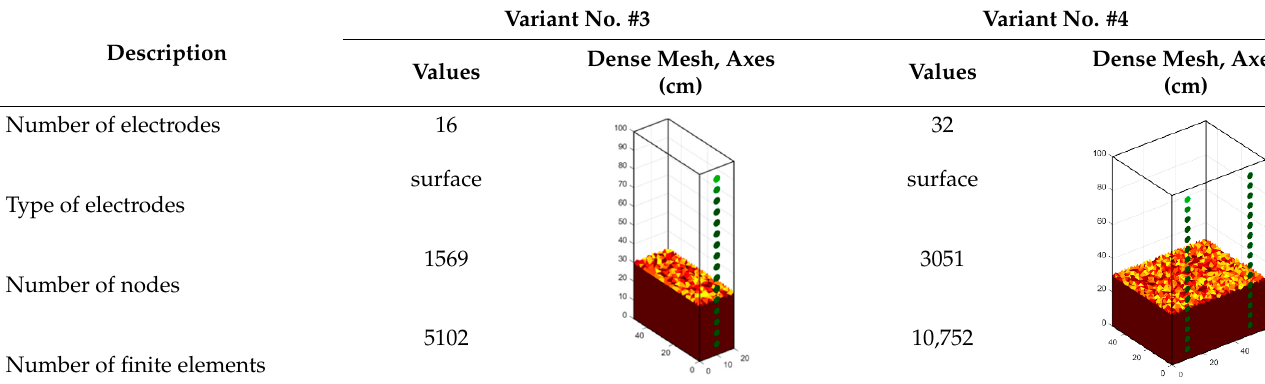
Table 4. Parameters of the finite element mesh – variants No. #3 and #4.